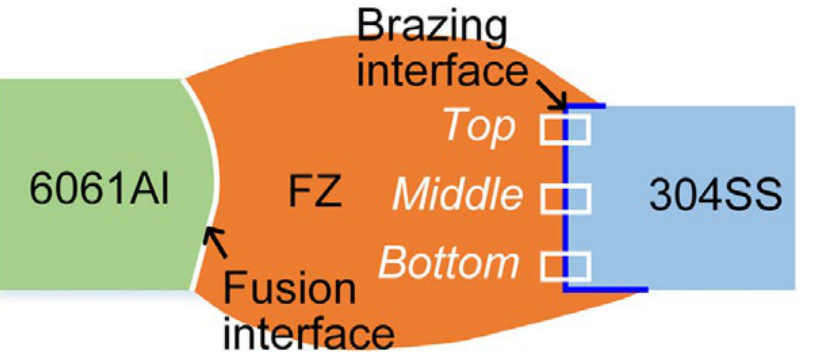
Figure 11. Diagram of offset and trajectory of the laser beam [33].